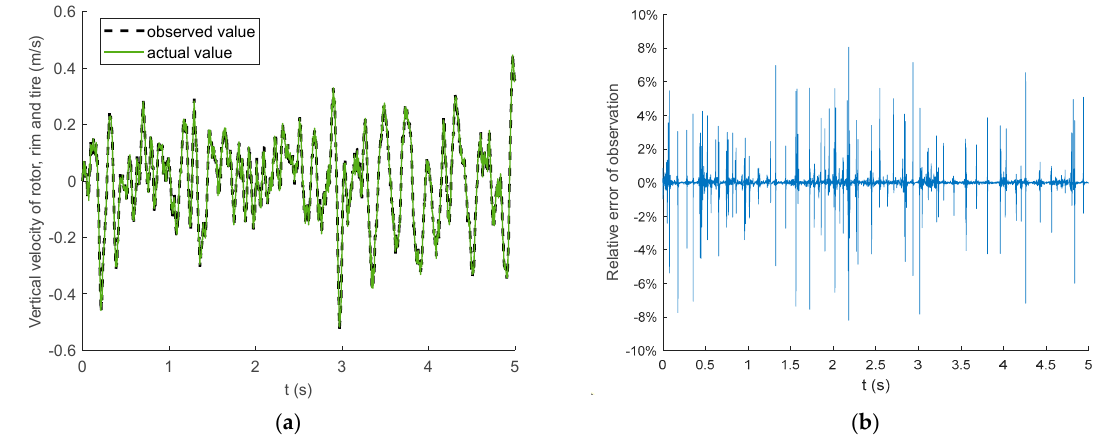
Figure 13. Observed results of vertical velocity of stator and residual unsprung mass. ( a ) Comparison of observed and actual values. ( b ) Relative error between observed and actual values.